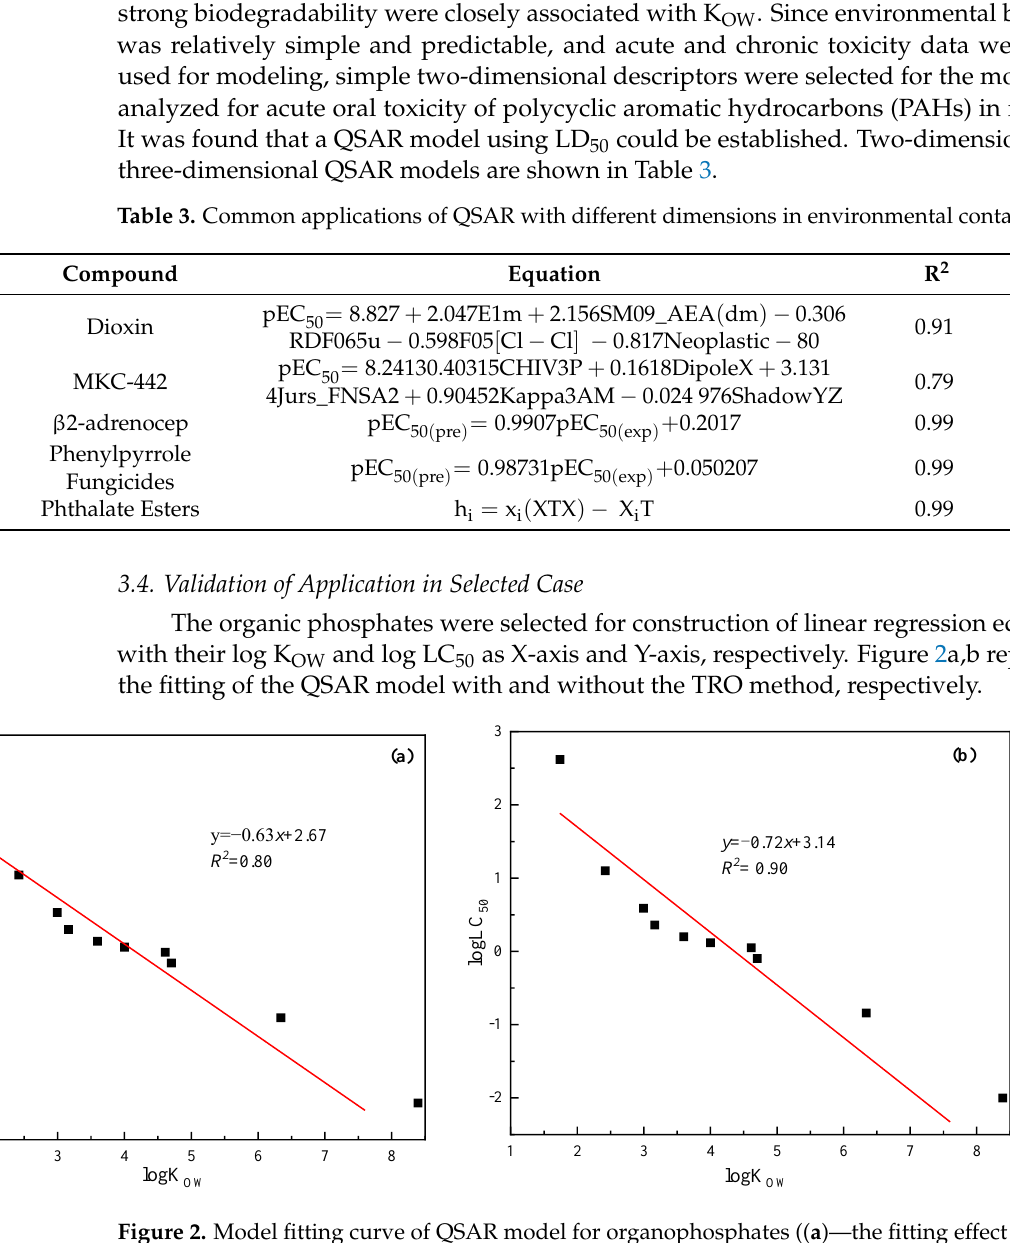
Figure 2. Model fitting curve of QSAR model for organophosphates (( a )—the fitting effect of QSAR model without TRO method; ( b )—the fitting effect of QSAR model with TRO method; The red line showed the fitting effect of the